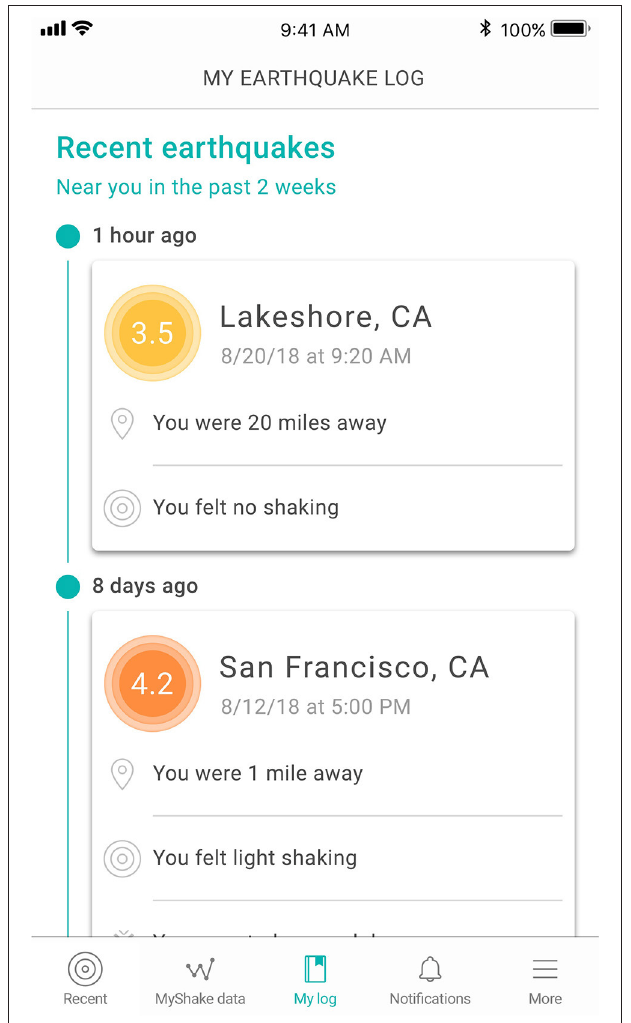
FIGURE 9 | Earthquake Log page showing hypothetical earthquakes and Experience Report responses to illustrate how a user could track their past experiences.